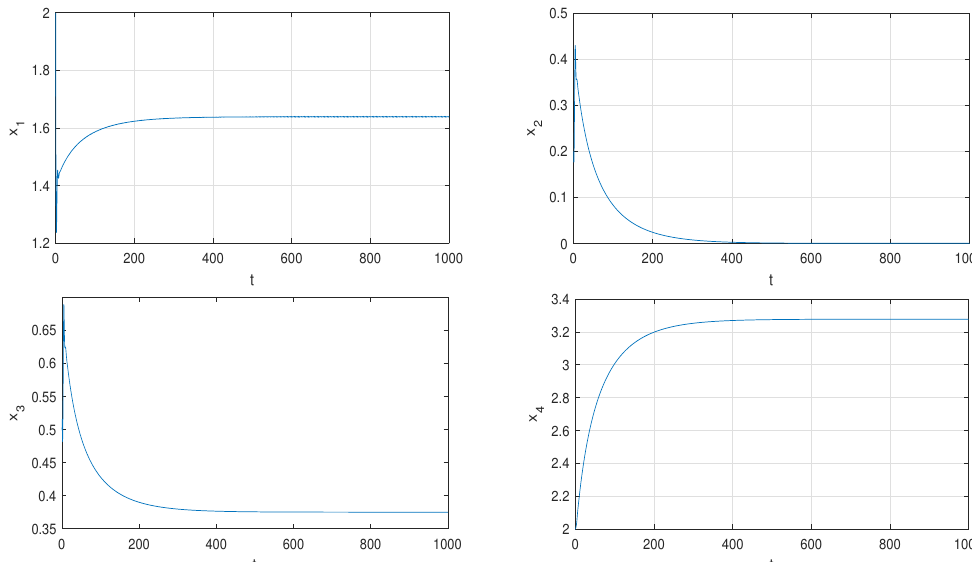
Figure 2. For the initial value ( x 1 , x 2 , x 3 , x 4 ) = ( 2,0.2,0.5,2 ) system (1) converges to the equilibrium point E ∗ = ( 1.6385,0,0.3750,3.2774 ) .